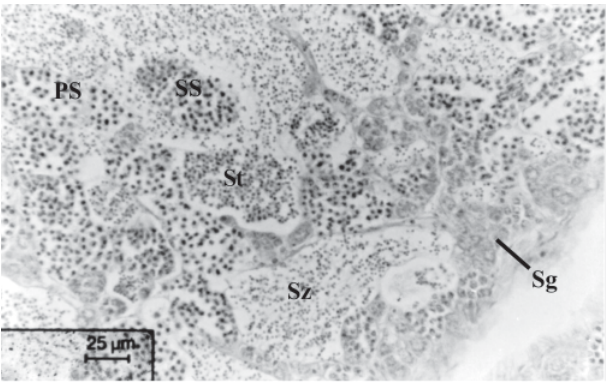
Fig. 11. Transverse section of the testicle of Mycteroperca bonaci showing the different development stages: spermatogonia (Sg), primary spermatocytes (PS), secondary spermatocytes (SS), spermatides (St) and spermatozoa (Sz). Stain: H. E.